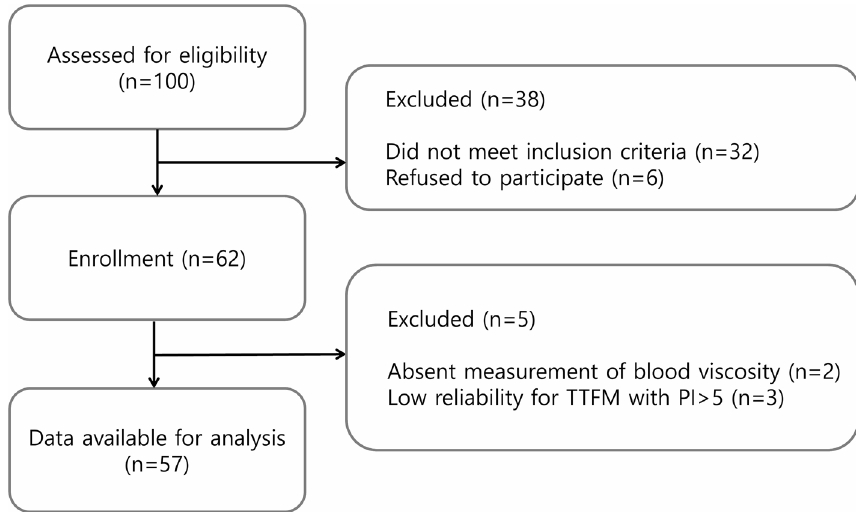
Figure 1. Flow diagram of the study. TTFM transit-time flow measurement, PI pulsatility